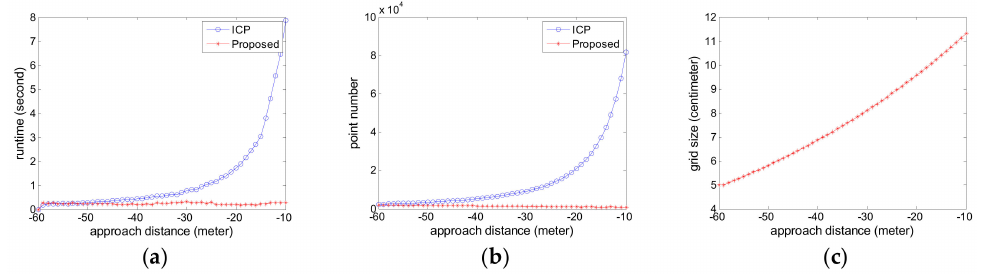
Figure 9. The runtime comparison in Experiment 1 ( a ) the runtime for each sensor data; ( b ) the point number of each sensor data; ( c ) the grid size used in the simplification process for each sensor data.